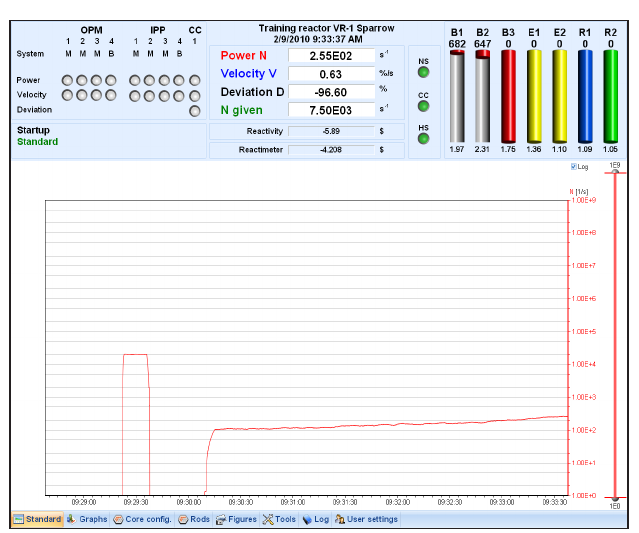
Fig. 3. Human machine interface of the VR-1 reactor